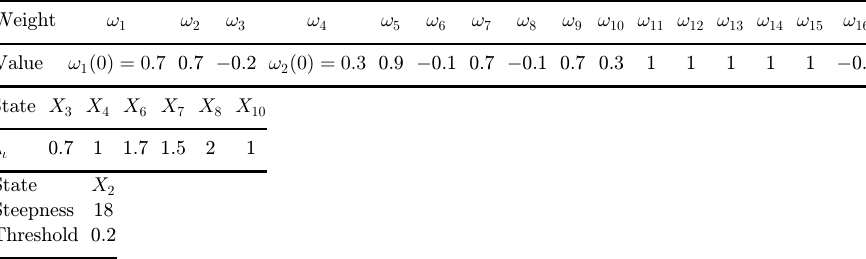
Table 3. Connection weights for the example simulation (Scenario 2).